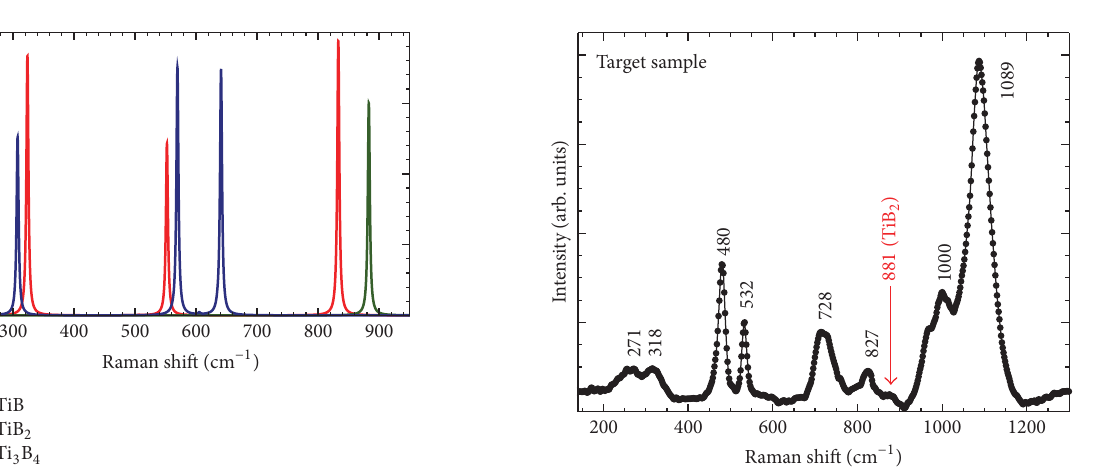
Figure 9: Experimental Raman spectrum of commercial TiB 2 target (Goodfellow, UK) measured at room temperature with laser excitation wavelength of 532